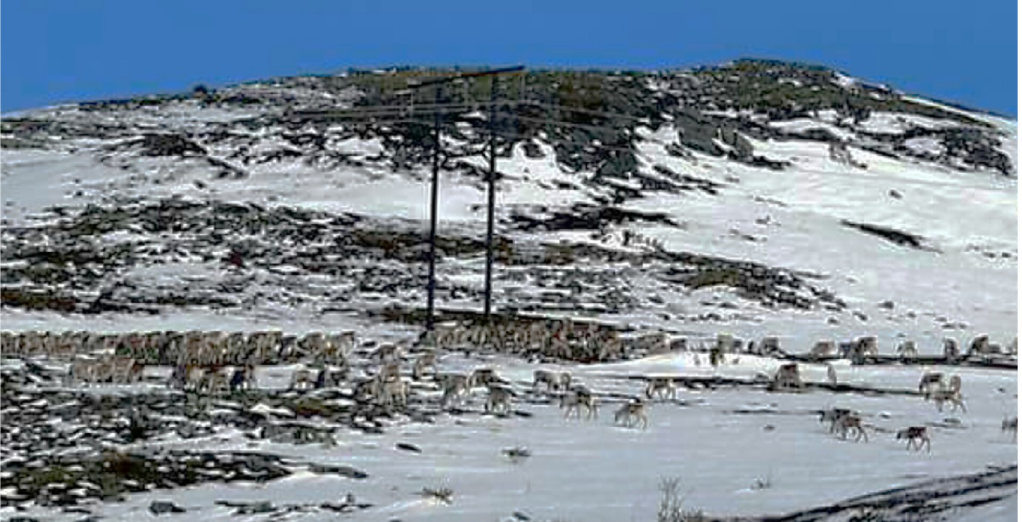
Figure 3. Wild reindeer movements/grazing under the 132 kV power line 31 March 2015 one year after the upgrading on their migration to their calving grounds in the central part of North Ottadalen. (Photo: Cecilie